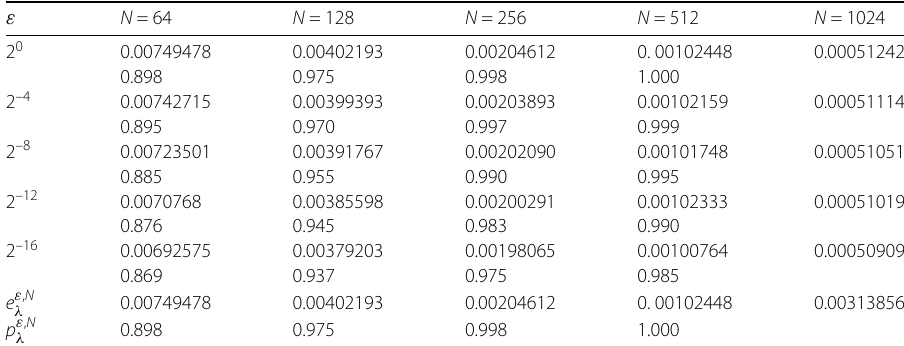
computed ε -uniform errors e N λ